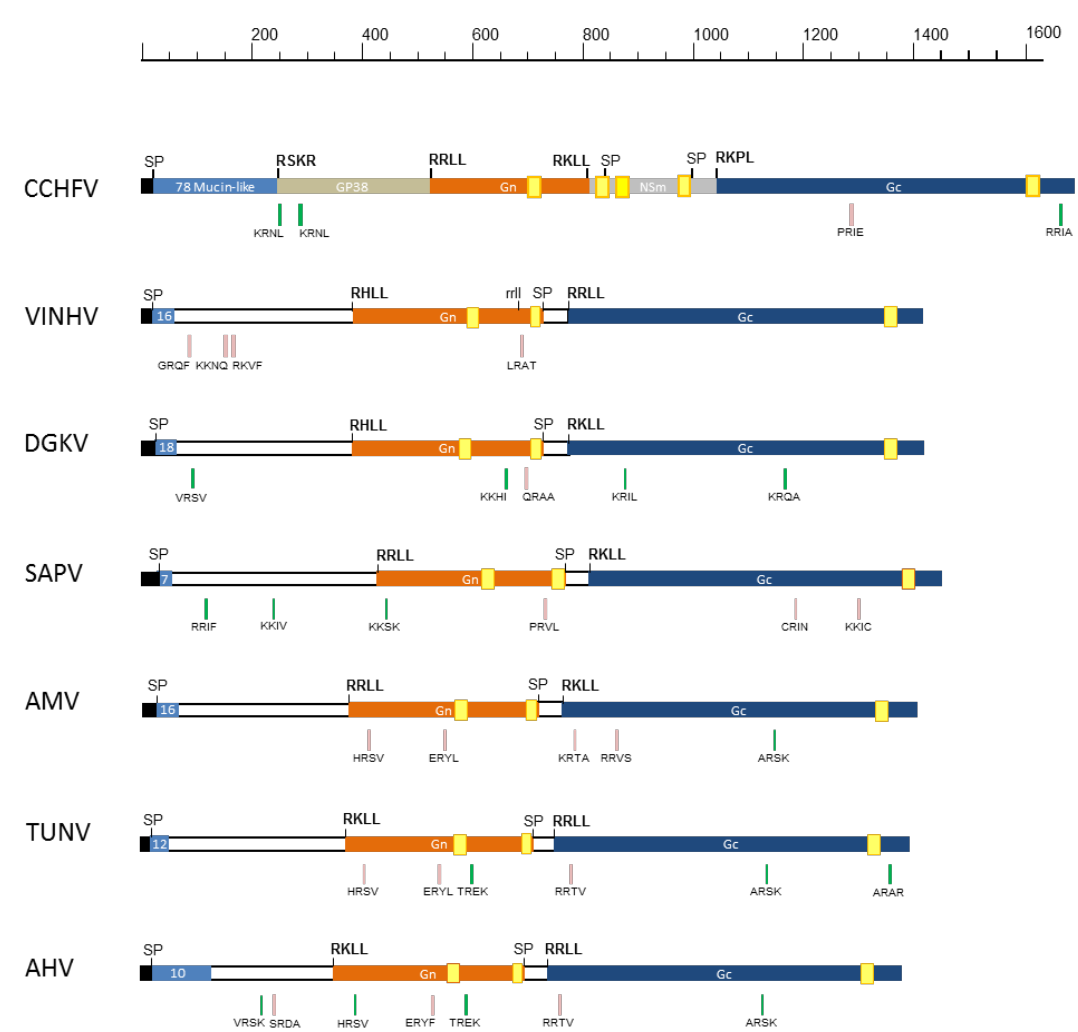
Figure 3. Illustration of the glycoprotein precursors (GPC) of VINHV and other DGK group nairoviruses. The CCHFV GPC is included as a reference for comparison. Regions corresponding to the mucin-like domain (light blue), GP38 (tan), Gn (orange), NSm (grey), and Gc (dark blue) are depicted. The numbers of predicted O-linked glycosylation sites in the mucin-like domain are shown. Signal peptidase cleavage sites (SP), potential furin-like (for CCHFV only) and subtilisin/kexin-isozyme-1 (SKI-I) cleavage sites that might be utilised to generate the individual proteins, were predicted using SignalP 4.1 and comparative studies and are shown above each schematic. A potential alternate cleavage site (rrll) identified in the VINHV protein is depicted in lower case. Transmembrane domains are indicated by yellow boxes. Additional cleavage sites predicted by ProP1.0 are indicated below the schematic with a green stripe (scores > 0.5, higher confidence) or a pink stripe (scores 0.3–0.49, lower confidence). DGKV: Dera Ghazi Khan virus; SAPV: Sapphire II virus; AMV: Abu Mina virus; TUNV: Tunis virus; AHV: Abu Hammad